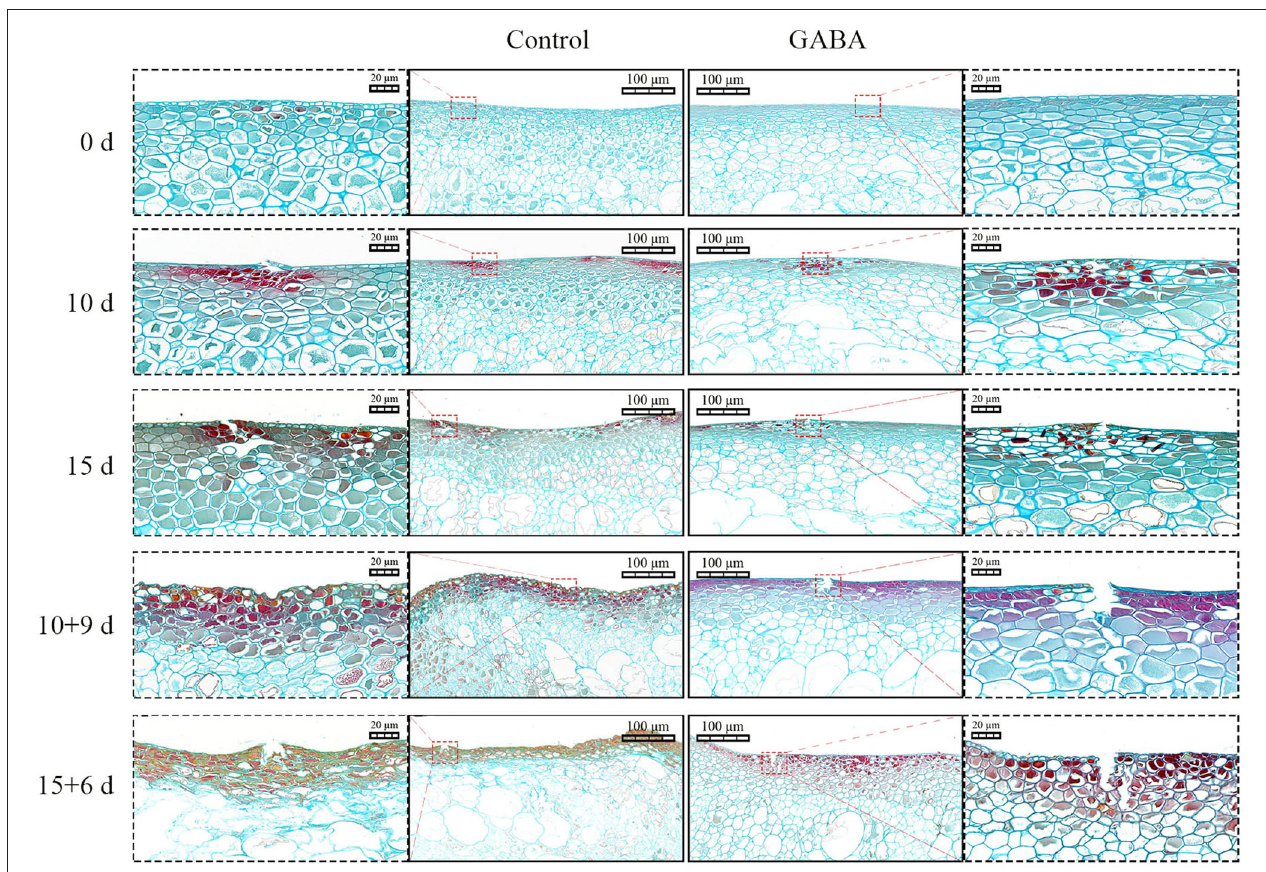
FIGURE 5 | The light microscopy images of a transverse section stained with safranin O/fast green of carambola fruit tissues stored at 4 and 25 ◦ C. The red dotted squares indicate the injured cell wall. Scale bars = 20 and 100 µ